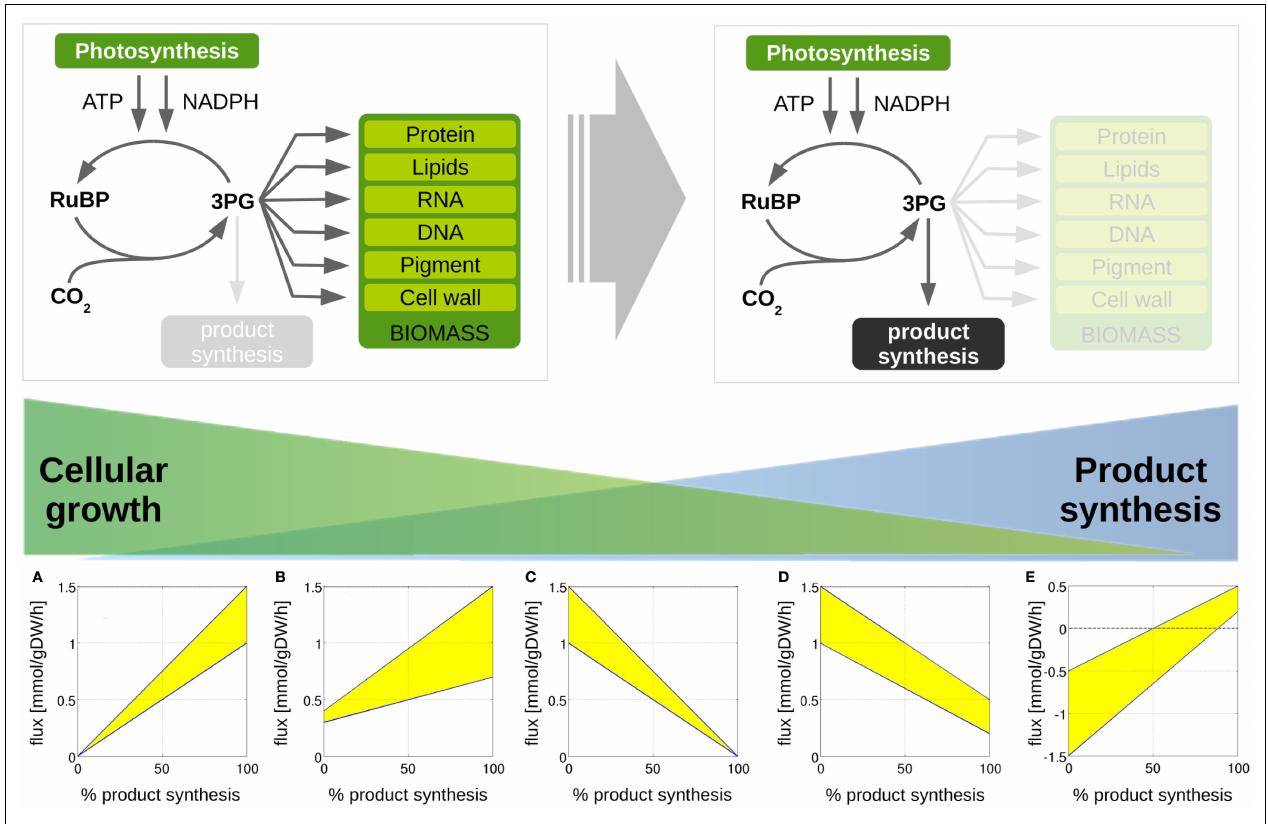
flux is only active during growth and attains a zero value for product synthesis, (D) the predicted reaction flux for growth is larger than the flux required for product synthesis, (E) the reaction flux changes sign during the transition for a growth phenotype to a production phenotype. We note that predicted flux solutions are not unique. The shaded areas indicate regions of computationally equivalent solutions (flux